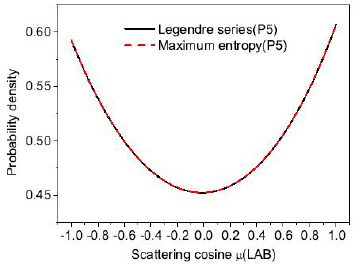
Figure 3. Exponential representation compared to the Legendre series truncated at order 5 for neutron scattering from group 88 to group 116